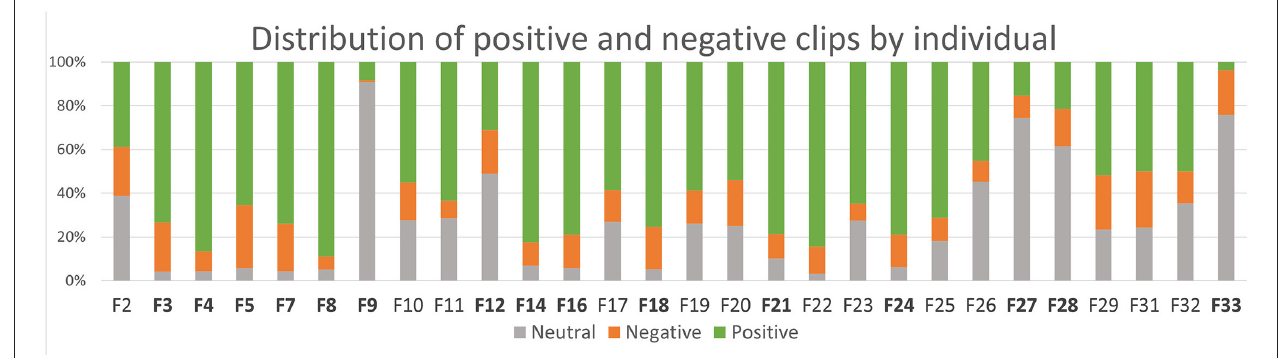
FIGURE 2 | Distributions of neutral, negative and positive clips for each participant. Each distribution is compared to the mean, expected distribution through a χ 2 test, and individuals who significantly deviate from the mean are presented by bolding the identifier, the same as in Figure 3